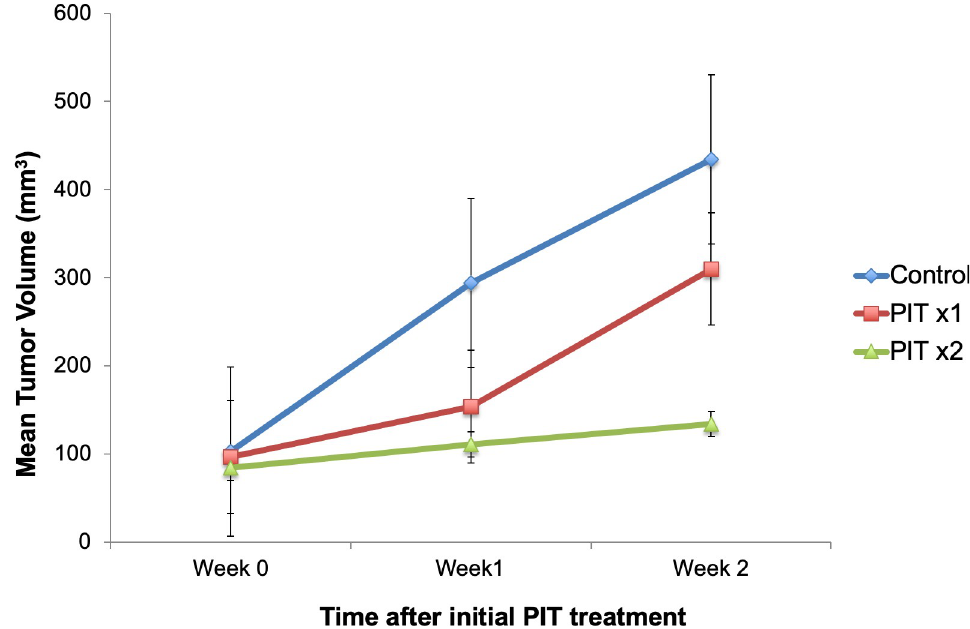
Fig 4. Tumor volume over time. PIT was delivered to both treatment groups at week 0. PITx2 group received repeated PIT at week 1. There was a significant difference between PITx2 tumor volume and control tumor volume at week 2 (p <